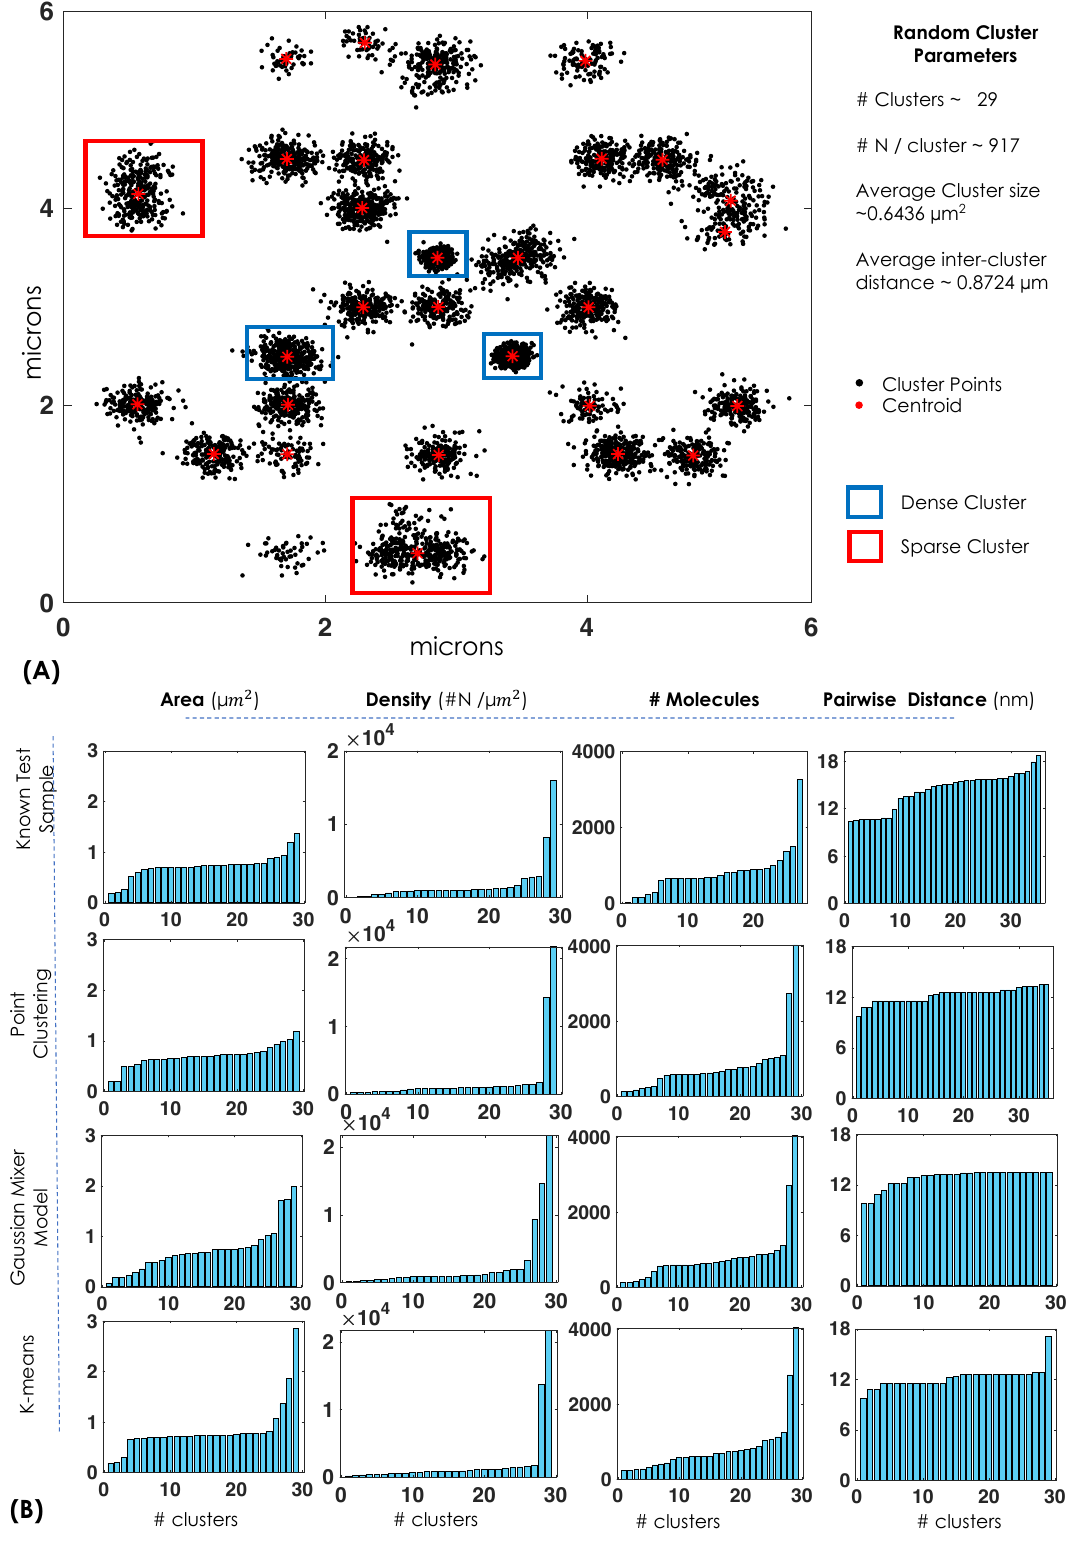
Figure 3. ( A , B ) Test samples (random clusters) with specific cluster parameters are generated to evaluate performance of clustering methods. The biophysical parameters (cluster area, cluster density, number of molecules, and pairwise distance) as estimated by clustering methods (K-means, Gaussian-mixture model, and point-clustering) are displayed for 29